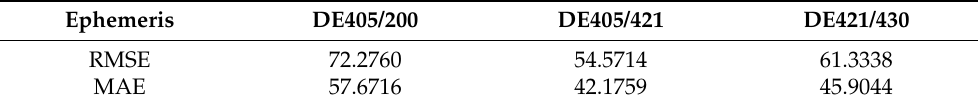
Table 5. Comparison of RMSE and MAE values (unit: µ